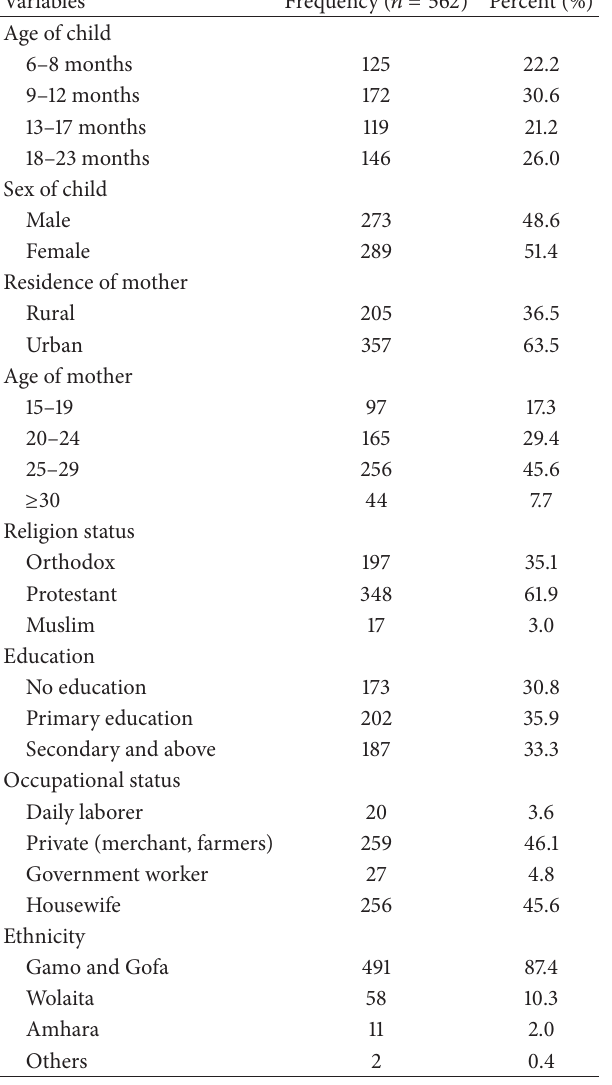
Table 1: Sociodemographic characteristics of mothers, who had infant aged from 6–23 months, who live in Kemba Woreda, 2014/15.